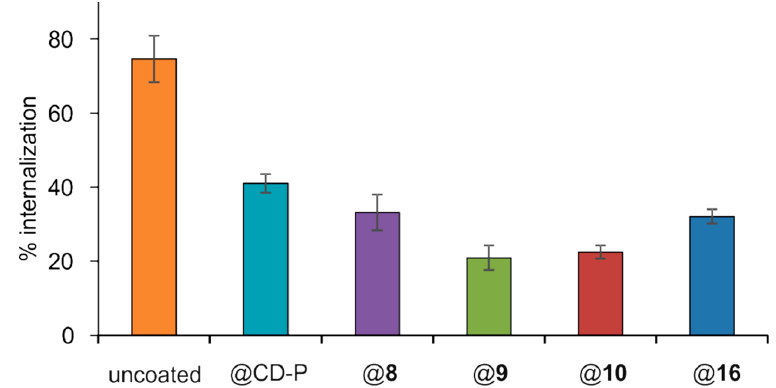
Figure 6. In vitro interaction of uncoated and coated nanoMOFs with PCDs CD-P, 8 – 10, and 16 with a J774A.1 macrophage cell line. 50 μ g/mL nanoMOFs were incubated with 3 × 10 5 J774A.1 cells for